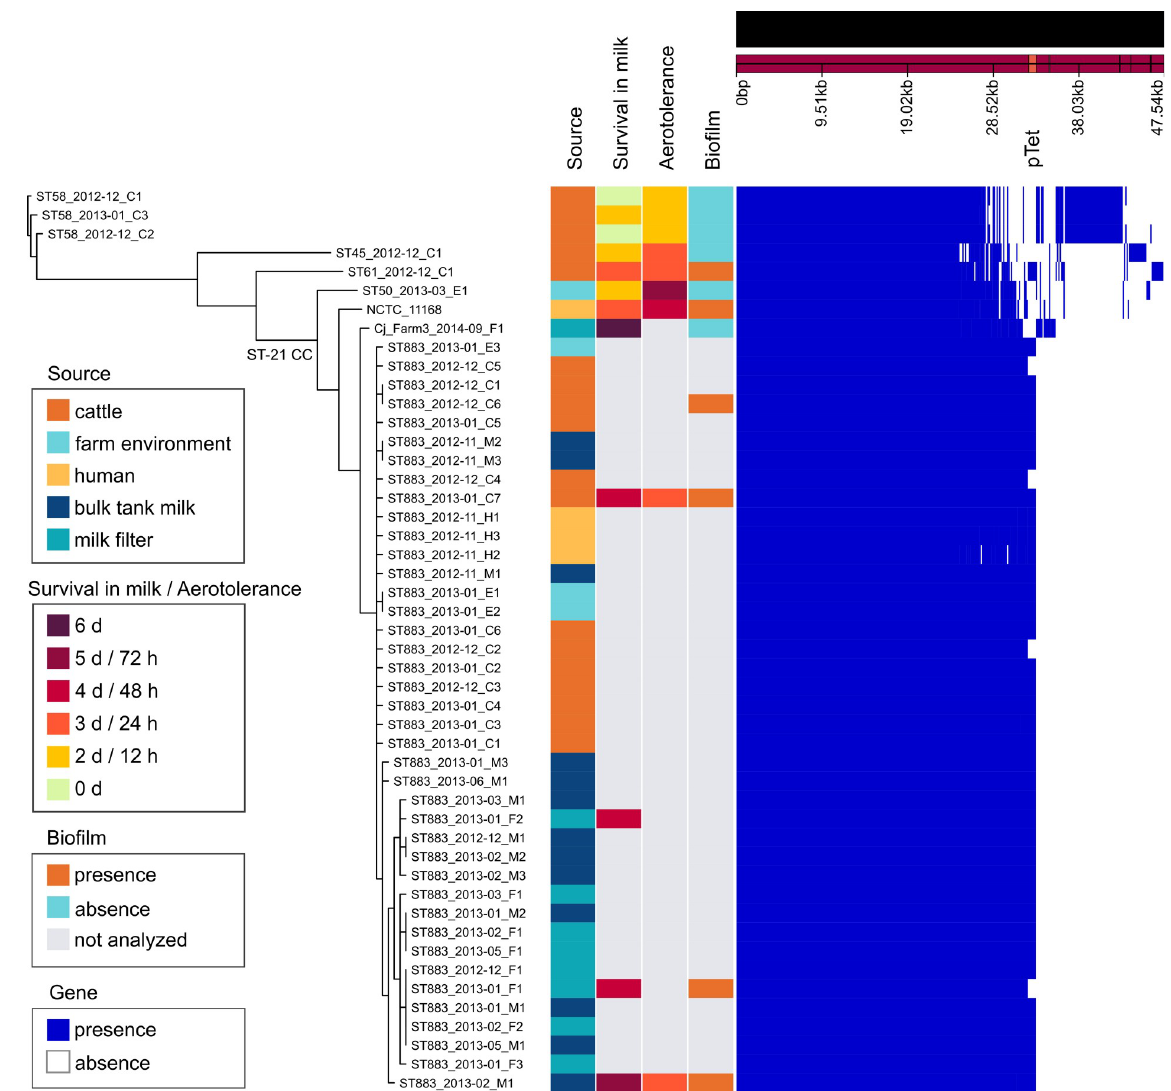
Fig 5. Genomic comparison of C . jejuni isolates from the outbreak farm. The reference strain NCTC 11168 (RefSeq accession no. NC_002163.1) and ST-883 isolate (Cj_Farm3_2014–09_F1) from another dairy farm [11] are included in the comparison. (A) Left pane: Approximation of maximum-likelihood phylogeny based on the nucleotide alignment of 1356 core genes from Roary using FastTree (version 2.1.9) with the GTR+CAT model [13]. Branches with support < 1 are not shown and recombinations are not masked. Names of the farm isolates indicate: ST, sampling time (year-month), sample source (C, E, H, M, or F; see legend), and isolate number. Middle pane: sample source and phenotype. Right pane: presence and absence of genes according to Roary.